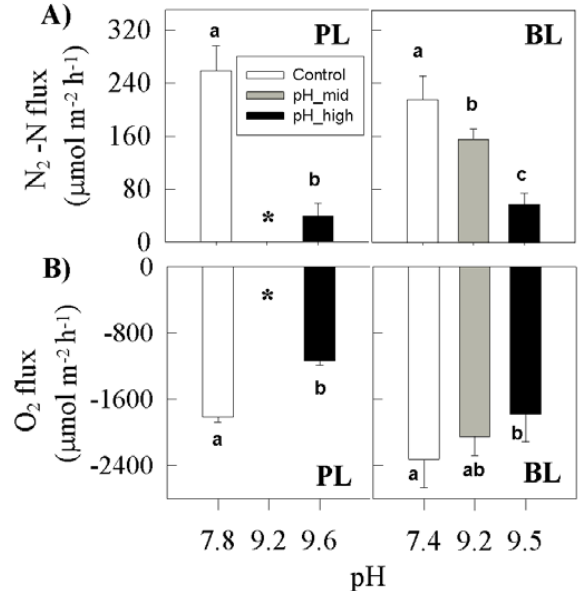
Figure 6. Experimental pH effects on denitrification rates (A) and oxygen consumption rates (B) of sediments from the Powerline (PL) and Budds Landing (BL) sites. “*” indicates where measurements were not taken. Bars show the mean of triplicate cores, error bars are the standard error of the mean. Different letters are used to show significant difference (Tukey’s test, P ≤ 0 . 05) due to pH changes at PL and BL, respectively.